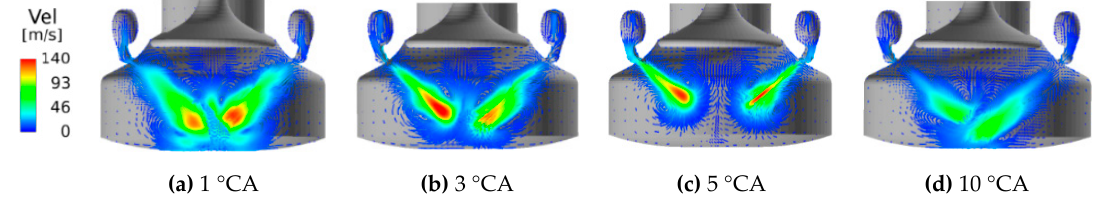
Figure 19. Flame velocity vector distribution.